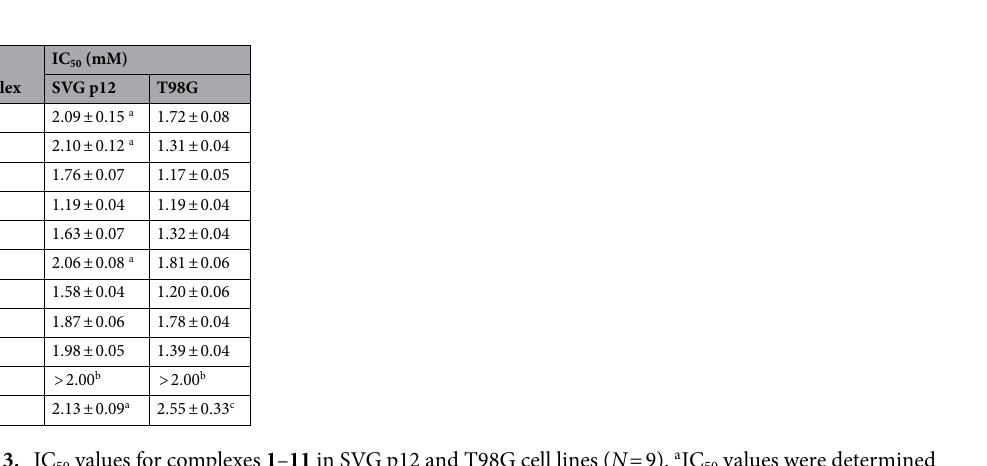
Table 3. IC 50 values for complexes 1 – 11 in SVG p12 and T98G cell lines ( N = 9). a IC 50 values were determined by means of the GraphPad Prism 7 non-linear regression analysis tool. b Value too large to accurately predict using available data between 62.5 μM and 2 mM. c Value reported previously (N = 4) in Ref. 8 .